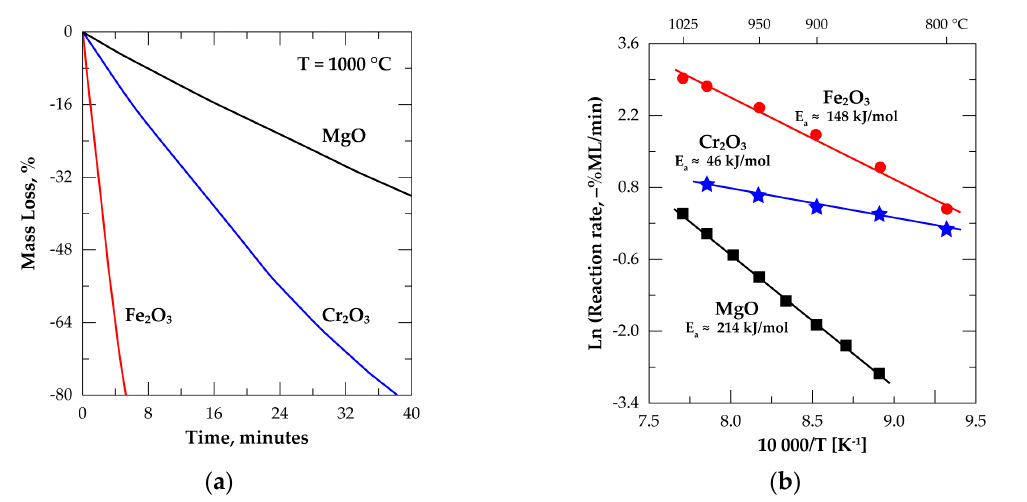
Figure 16. Treatment of Fe 2 O 3 , Cr 2 O 3 and MgO in chlorine in presence of oxygen: ( a ) Evolution of the sample mass loss versus time at 1000 °C; ( b ) Arrhenius diagrams between 800 and 1025 °C. sample mass loss versus time at 1000 ◦ C; ( b ) Arrhenius diagrams between 800 and 1025 ◦